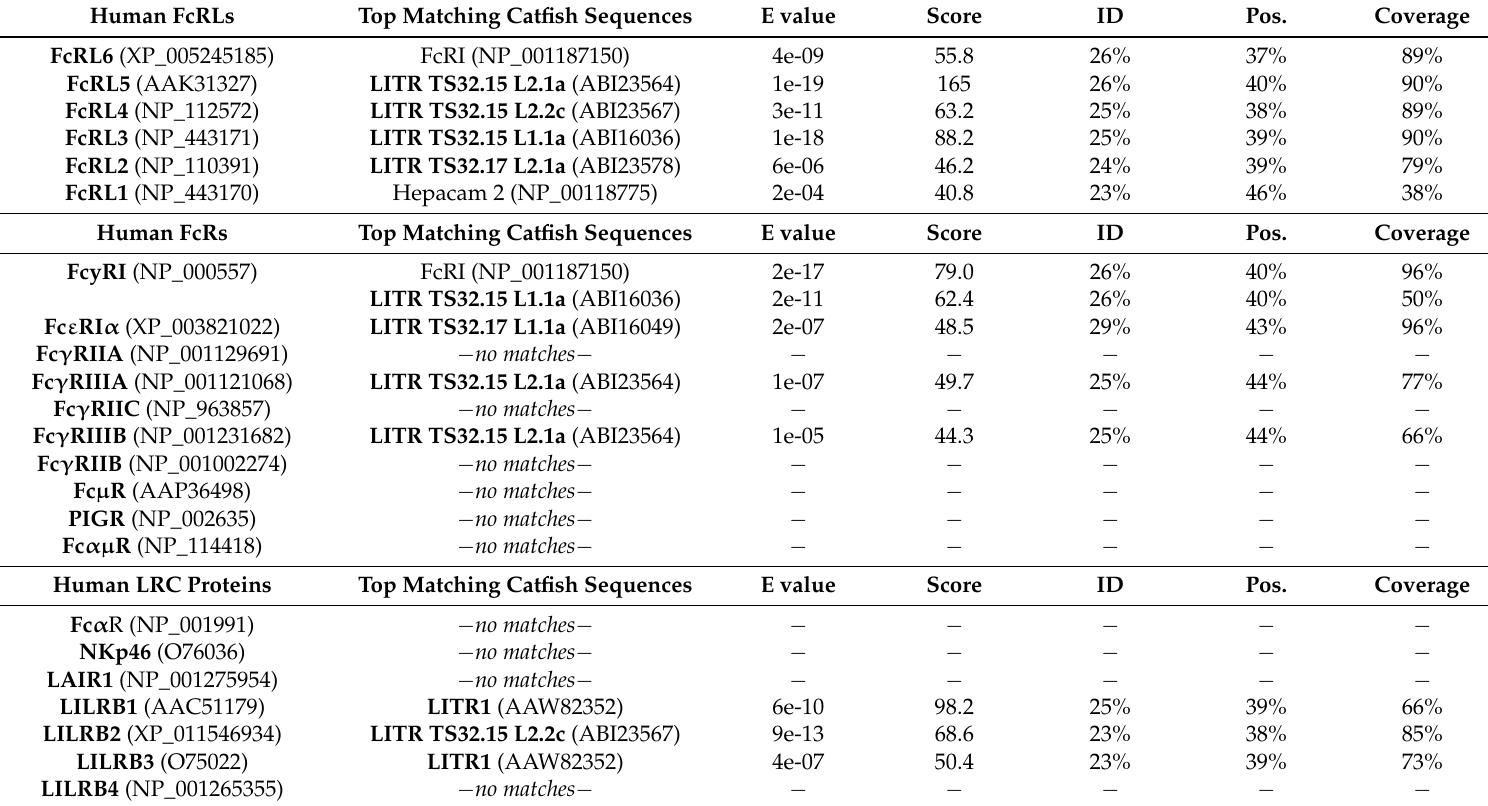
Table 1. Protein basic local alignment search tool (BLASTp) searches for vertebrate immunoregulatory receptor-like sequences and intracellular signaling proteins in the Channel catfish ( Ictalurus punctatus